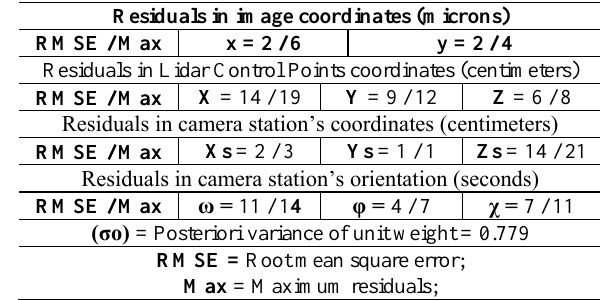
Table 2. Estimated IOP from the in situ camera calibration and